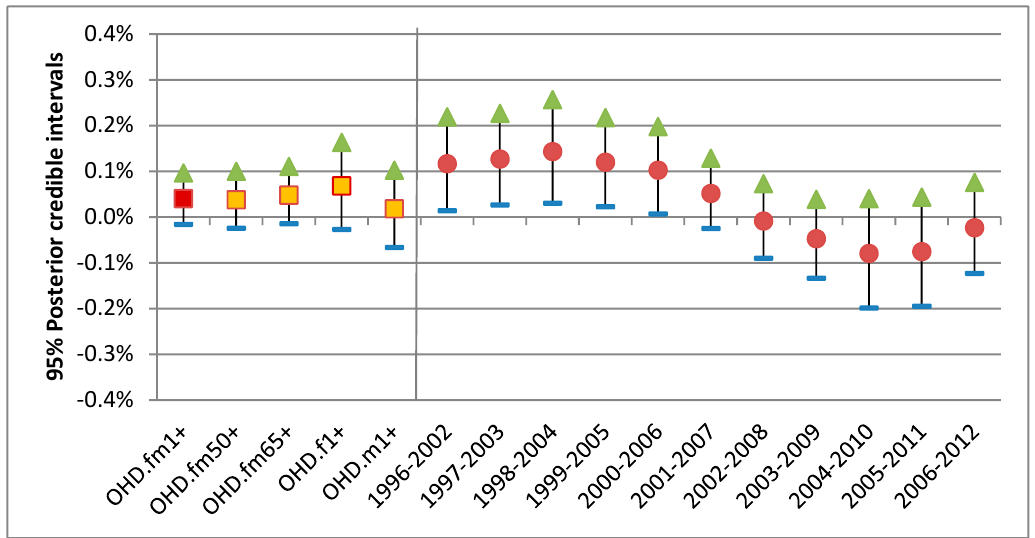
Figure 7. A total of 95% posterior intervals for the associations per 10 ppb 1-day lagged ozone with OHD hospitalizations for warm season: ( a ) 17 years combined risks for 5 groups (squares); ( b ) 11 annual risks of base group (circles in red).